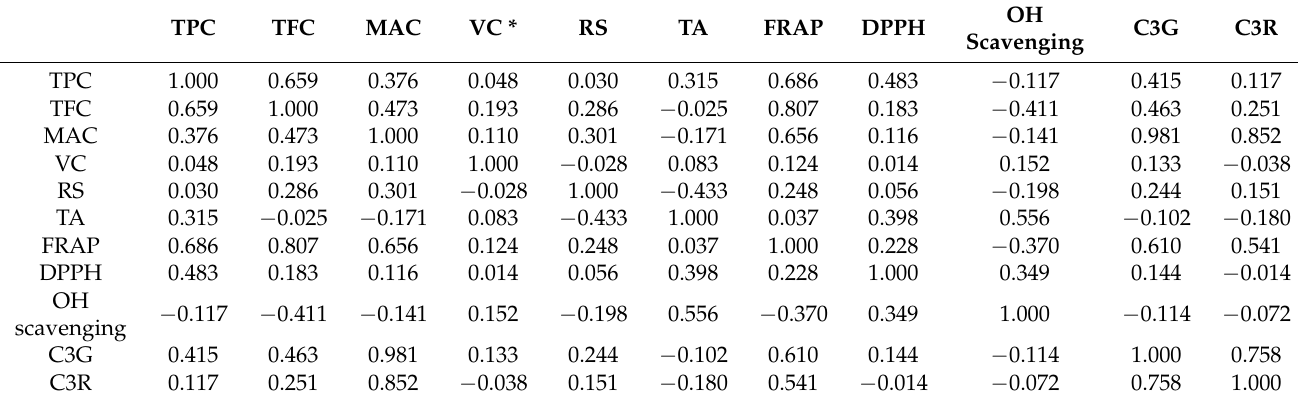
Table 4. The correlation coefficients of the contents of total phenolic, total flavonoid, main an- thocyanin, vitamin C, reducing sugar, titratable acidity, antioxidant capacity (FRAP, DPPH, hy- droxyl radical scavenging capacity) and the main anthocyanin (cyanidin-3- O -glucoside, cyanidin-3- O